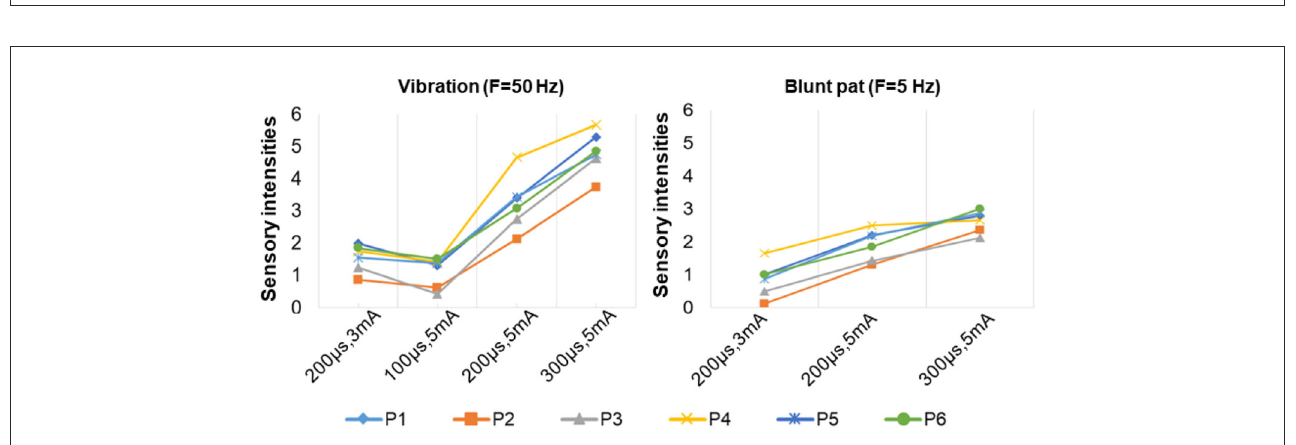
FIGURE8 The relationship between sensation intensity and the stimulus parameters under the SS mode (the stimulus was 5 and 50Hz).